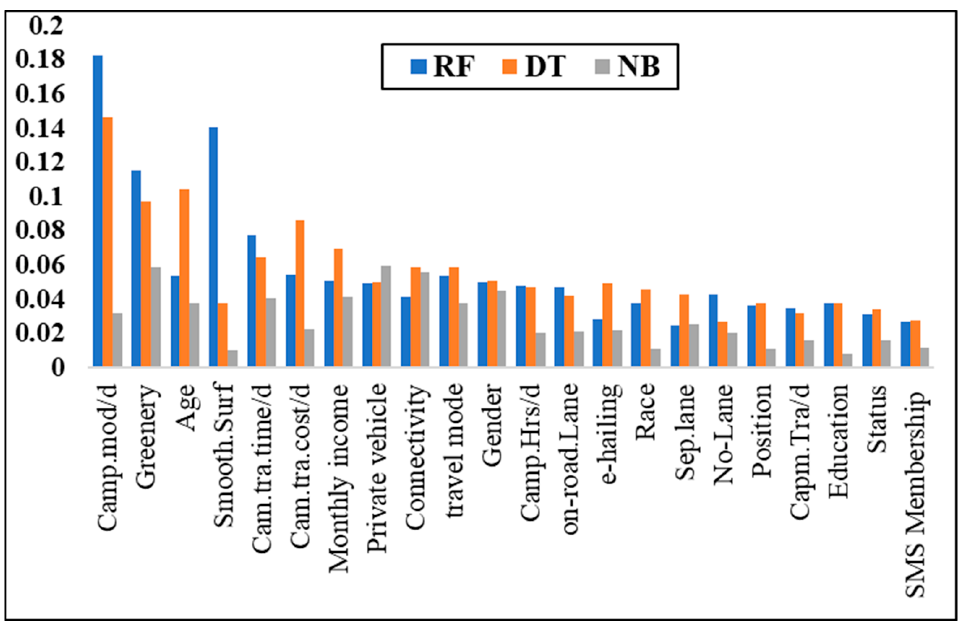
Figure 11. Importance score (weight) of variables based on three ML methods.